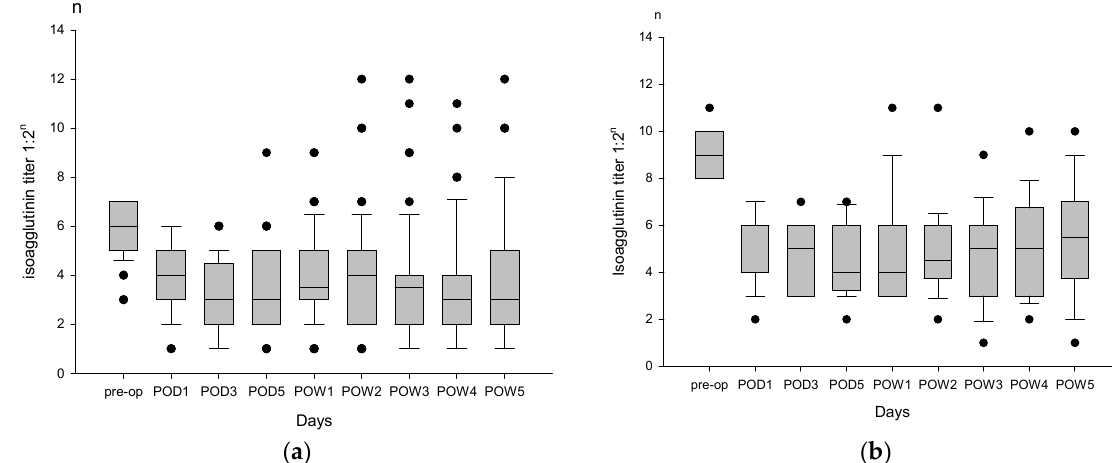
Figure 2. Isoagglutinin titers at pre-operation and post-operation within the first five weeks after liver transplantation. ( a ) Six of 56 patients in group A had postoperative isoagglutinin rebound (titers ≥ 1:128). Among the six patients, the rebound of isoagglutinin titers was up to 1:128 in two patients, 1:512 in one patient, 1:1024 in one patient, and 1:4096 in two patients. ( b ) 10 of 20 patients in group B had isoagglutinin rebound. The rebound of isoagglutinin titers was up to 1:128 in seven patients, 1:256 in one patient, and 1:2048 in two patients.